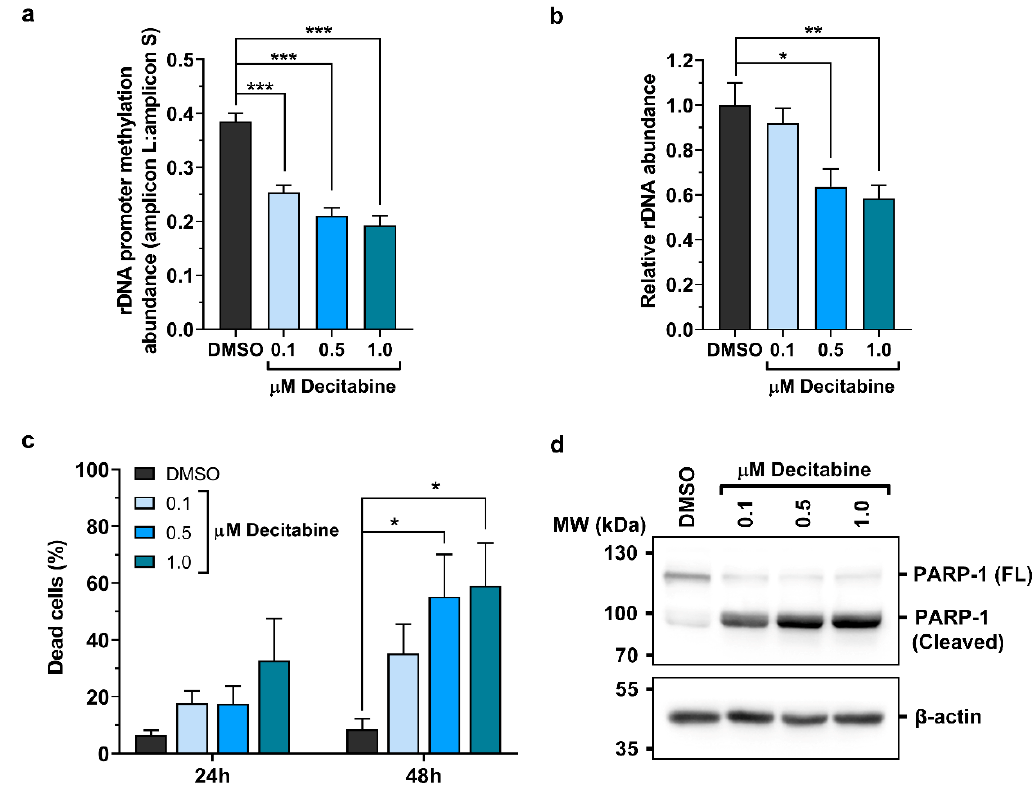
Figure 3. Death of E µ - Myc lymphoma cells by promoter hypomethylation and destabilization of rDNA. 152M cells were treated with vehicle (DMSO) or with 0.1, 0.5, and 1.0 µ M of the DNMT inhibitor Decitabine for 48 h. ( a ) Changes in rDNA promoter methylation between treated and untreated cells were monitored by DNA digestion with Hpa II and subsequent qPCR analysis of amplicons L and S. ( b ) Genomic DNA was used as template in qPCR with primer pairs for either the rDNA promoter or the Rab5c gene promoter. Abundance of rDNA was expressed relative to Rab5c . ( c ) Viability of cells treated with DMSO or Decitabine for the indicated times was monitored by Trypan Blue staining. The percentage of dead, membrane-compromised cells that were stained is displayed. For statistical analysis a two-way ANOVA test with Tukey multiple comparisons was used. ( d ) Immunoblotting of PARP-1 showing cleavage of the full-length (FL) protein upon Decitabine treatment. β -actin served as a loading control. Densitometric analysis and uncropped western blot images are provided in Figure S4a. Bar diagrams represent mean values ± SEM from at least three biological replicates. * p < 0.05, ** p < 0.01, and *** p <